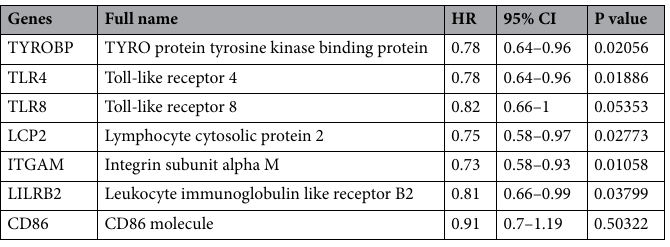
Table 1. Univariate Cox regression analyses to the hub genes.